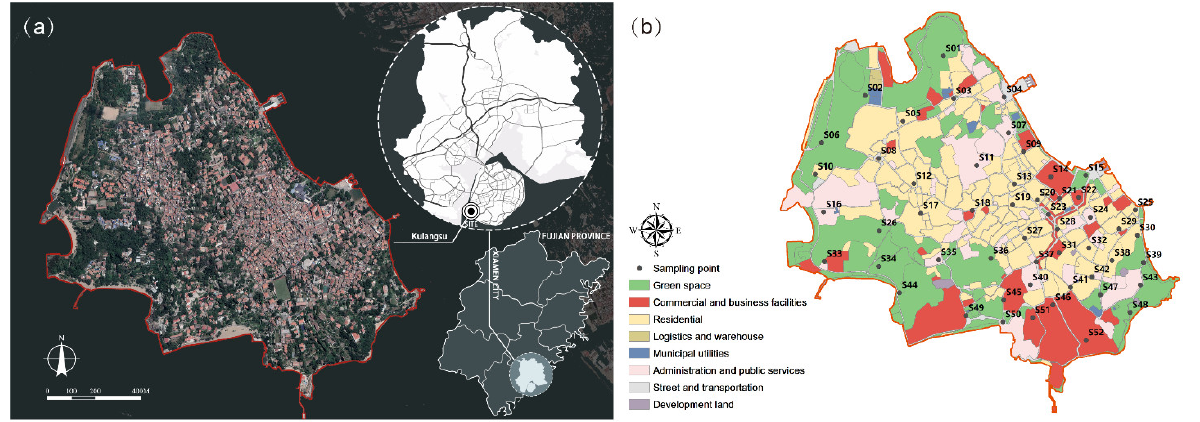
Figure 1. Case study area: ( a ) location of Kulangsu Island in Fujian Province, China; ( b ) land use type with sampling points.